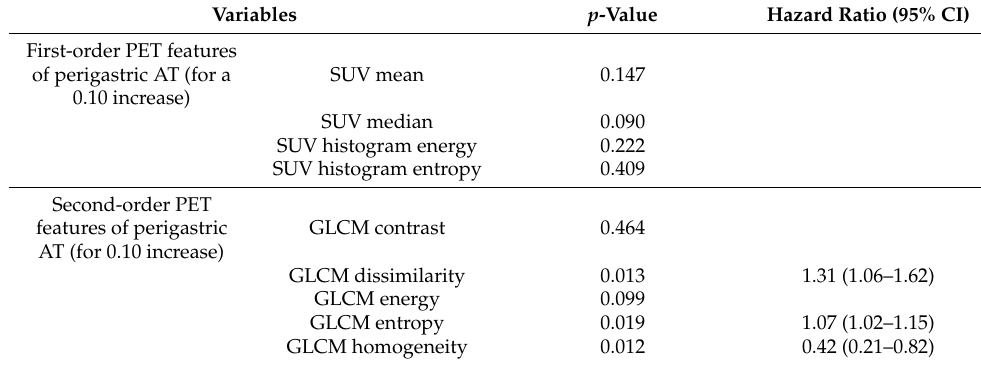
Table 4. Results of multivariate analysis of PET textural features for recurrence-free survival after adjustment for age, sex, TNM stage, and the maximum SUV of primary